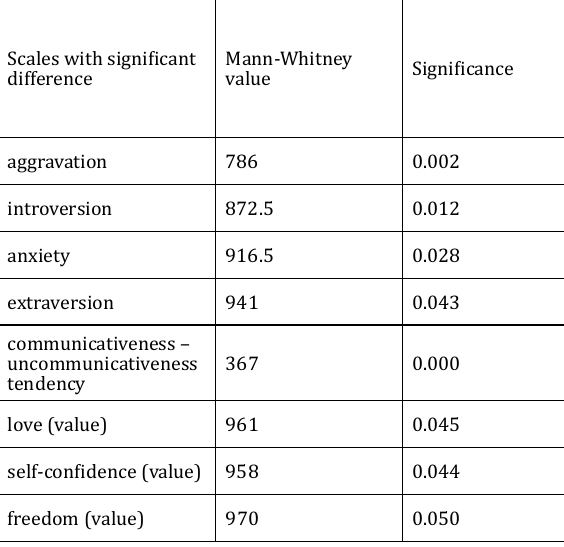
Table 5. Significant difference between two groups as